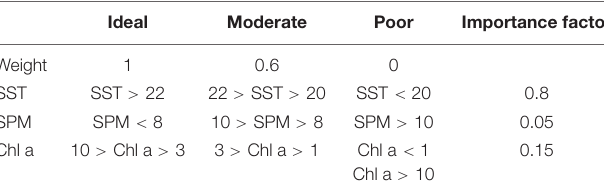
TABLE 4 | Values for oyster suitability index for the Gulf of Maine (adapted from Snyder et al., 2017).